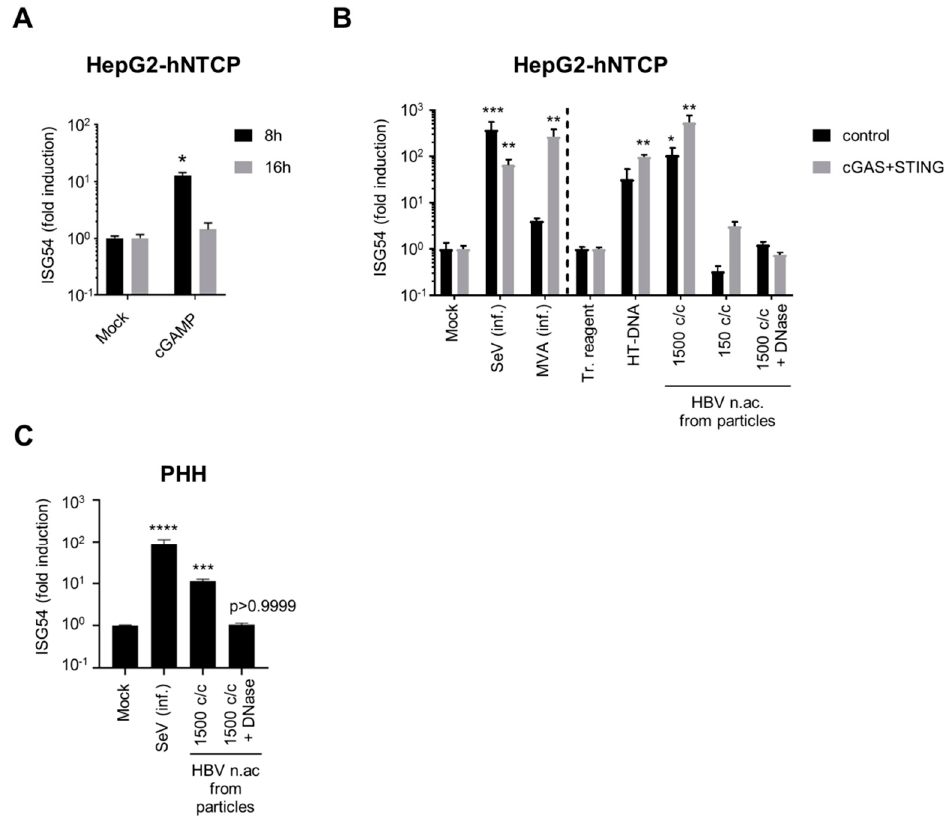
Figure 4. Hepatocytes respond to foreign DNA. HepG2-hNTCP ( A ), HepG2-hNTCP-control or -cGAS / STING ( B ) or PHH ( C ) were stimulated with cGAMP (A), infected (inf.) with SeV or MVA-gfp, or transfected with HT-DNA or HBV nucleic acids (c / c: copies / cells) ( B , C ). ISG54 mRNA fold inductions to mock (( A , B ) left part, ( C )) or to transfection reagent-treated cells (tr. reagent) (( B ), right part) was determined by RT-qPCR. Average and SEM of 4 ( A ), 2 ( B ) independent experiments in triplicates or of 4 donors in duplicates ( C ). Levels of significance compared to respective controls (( A , B ) left part, ( C ): mock; ( B ), right part: transfection reagent-treated cells): **** p < 0.0001, *** p < 0.001, ** p < 0.01, * p < 0.05 (2-way ANOVA with Sidak’s multiple comparisons ( A ); Kruskal–Wallis with Dunn’s test ( B , C )).